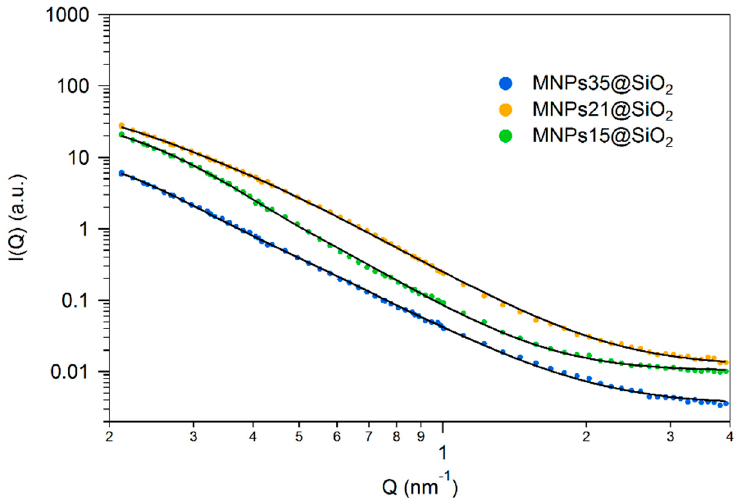
Figure 4. Small-angle neutron scattering (SANS) curves of the nanocomposites.